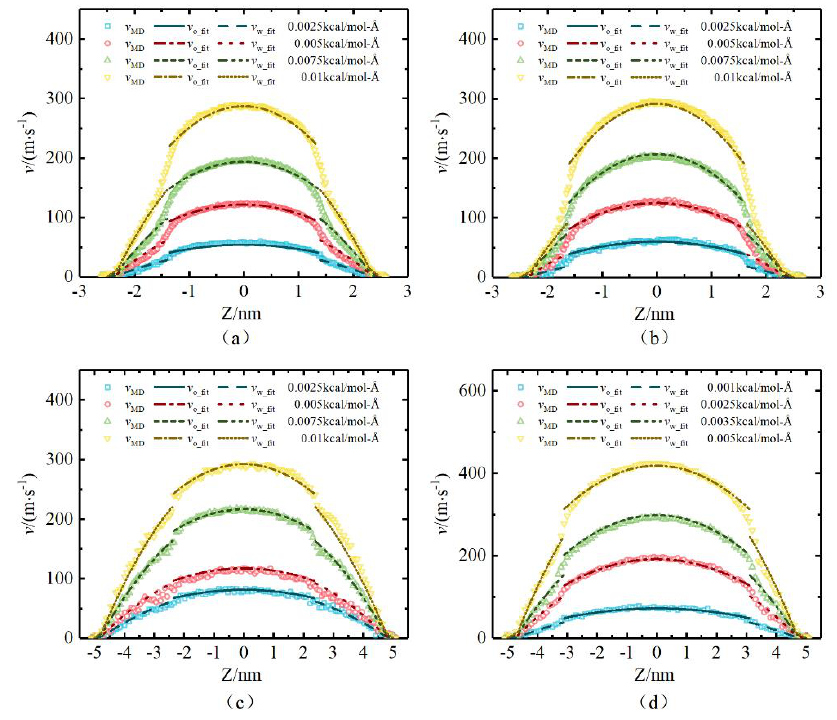
Figure 11. The comparisons of fluid velocity profiles in quartz nanopores calculated by “liquid − liquid slip” model with molecular simulation data: ( a ) 5nm pore with OMP = 50%; ( b ) 5 nm pore with OMP = 60%; ( c ) 10 nm pore with OMP = 40%; ( d ) 10 nm pore with OMP = 60%.